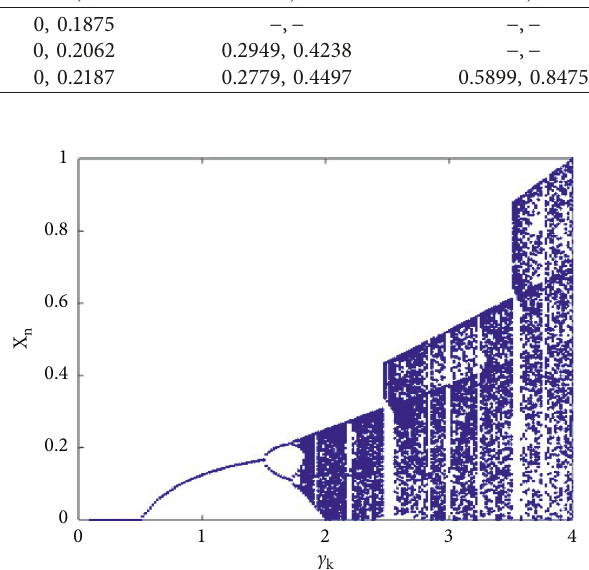
Figure 2: Bifurcation diagram of system